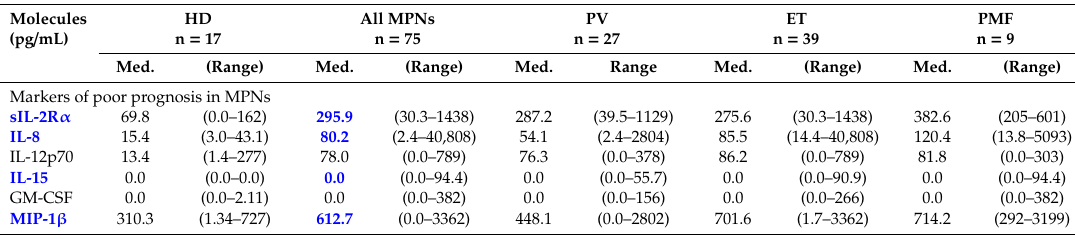
Table 2. Cytokine levels in MPN